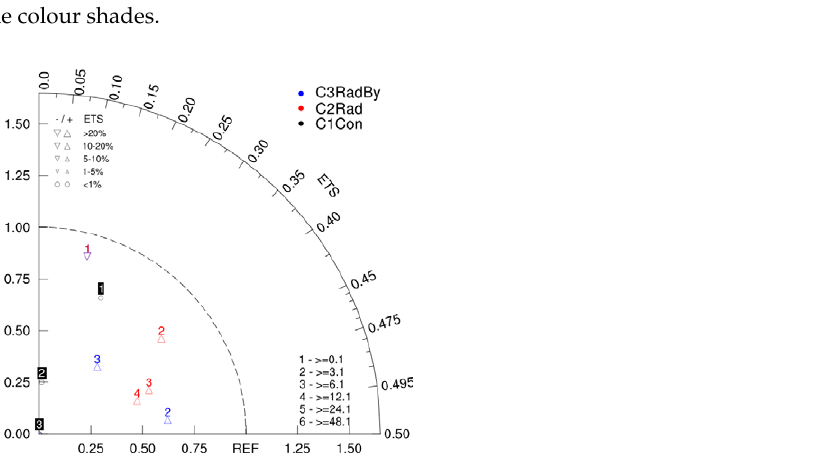
Figure 15. Taylor diagrams of the hourly accumulated precipitation forecast at 0900 UTC from 30 July 2019. The triangle and circle indicate the increased percentage of ETS relative to C1Con or E1Con which is the same below. which is the same